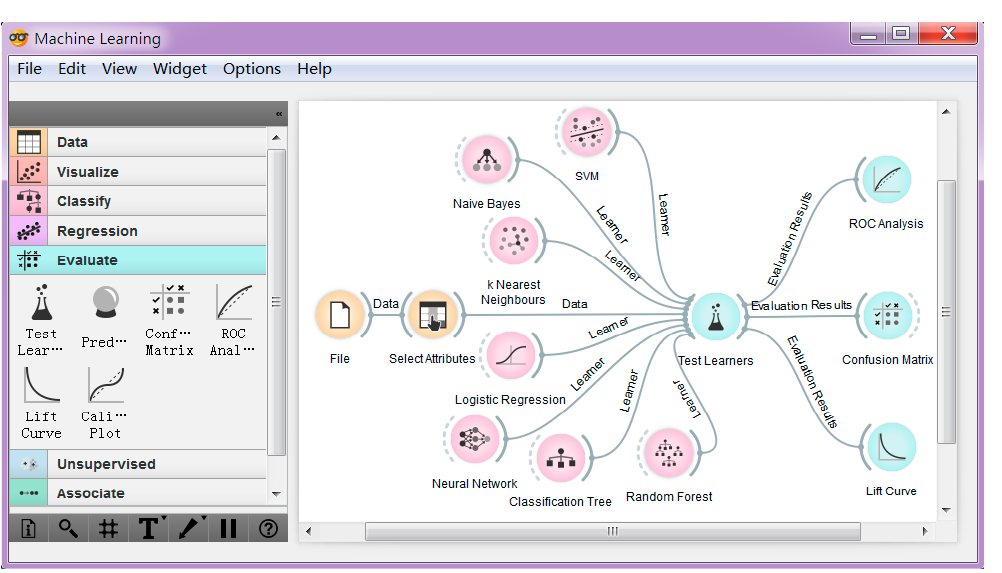
Figure 7. Workflow of the data classification using Orange toolkit.